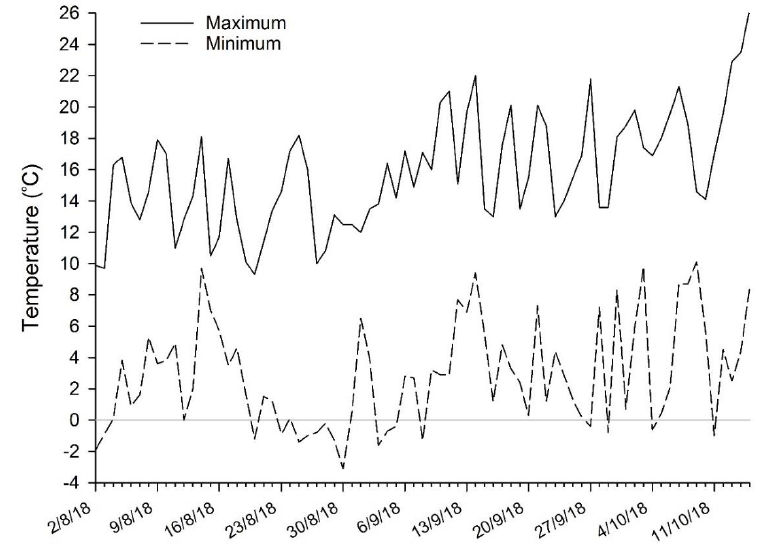
Figure 2. Maximum and minimum temperatures for the period from 2 August to 15 October 2018 (data obtained from Bureau of Meteorology station 95003 — Bushy Park, Tasmania). (data obtained from Bureau of Meteorology station 95003—Bushy Park, Tasmania).